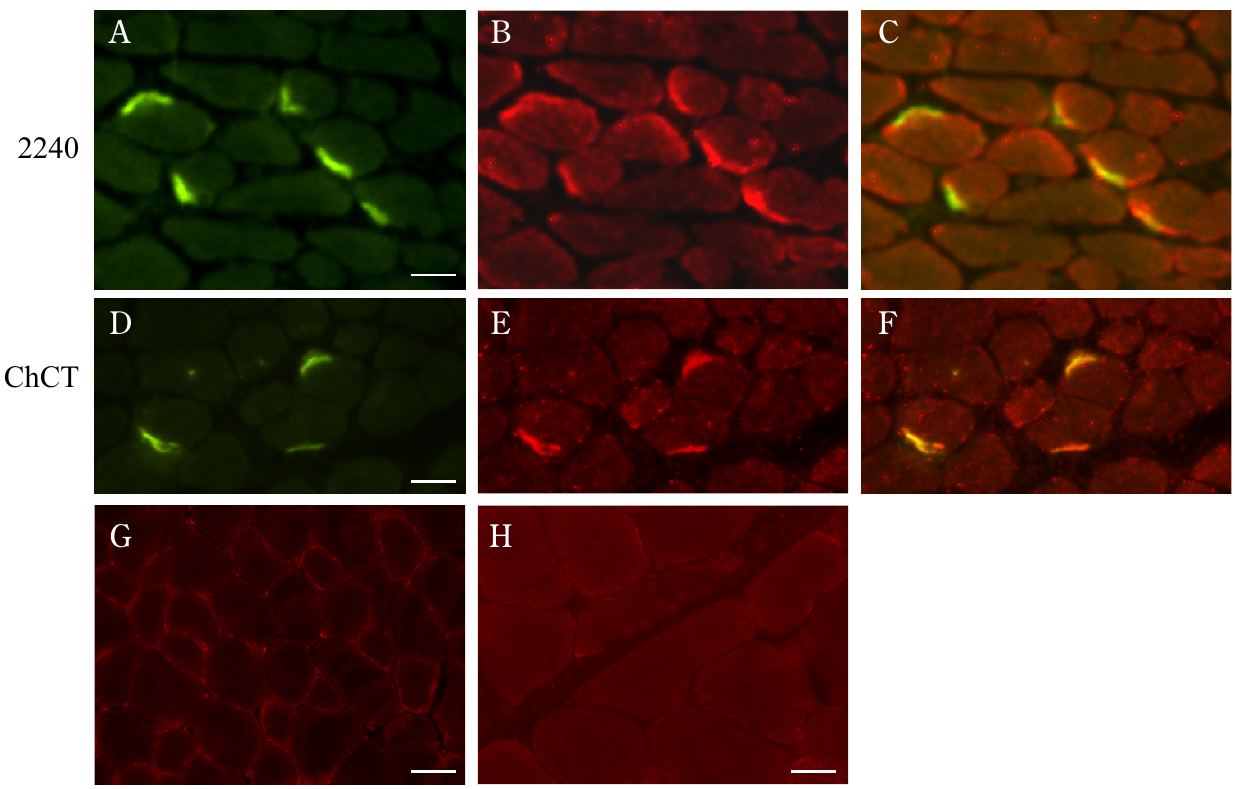
Figure 3 Immunolocalization of CAR to the neuromuscular junction in mouse skeletal muscle . Frozen sections of mouse muscle were incubated with Alexa Fluor-conjugated α -bungarotoxin and antibodies to CAR as described in Materials and Methods. Panels A and D show α -bungarotoxin staining of acetylcholine receptors at neuromuscular junctions (green). Panel B shows immunofluorescent staining of the section in panel A with a polyclonal antibody (ab 2240) to the extracellular domain of CAR (red). Panel E shows immunofluorescent staining of the section in panel D with a chicken polyclonal antibody (ChCT) directed against a C-terminal portion of CAR conserved in both CAR isoforms (red). Panel C is a merge of panels A and B . Panel F is a merge of panels D and E . These merges [ C, F ] show that CAR colocalizes with α -bungarotoxin at murine neu- romuscular junctions (in yellow). Sections incubated with the secondary antibodies alone did not give any signal – anti-rabbit IgG [ G ], anti-chicken IgY [ H ]. Bar = 35 µ